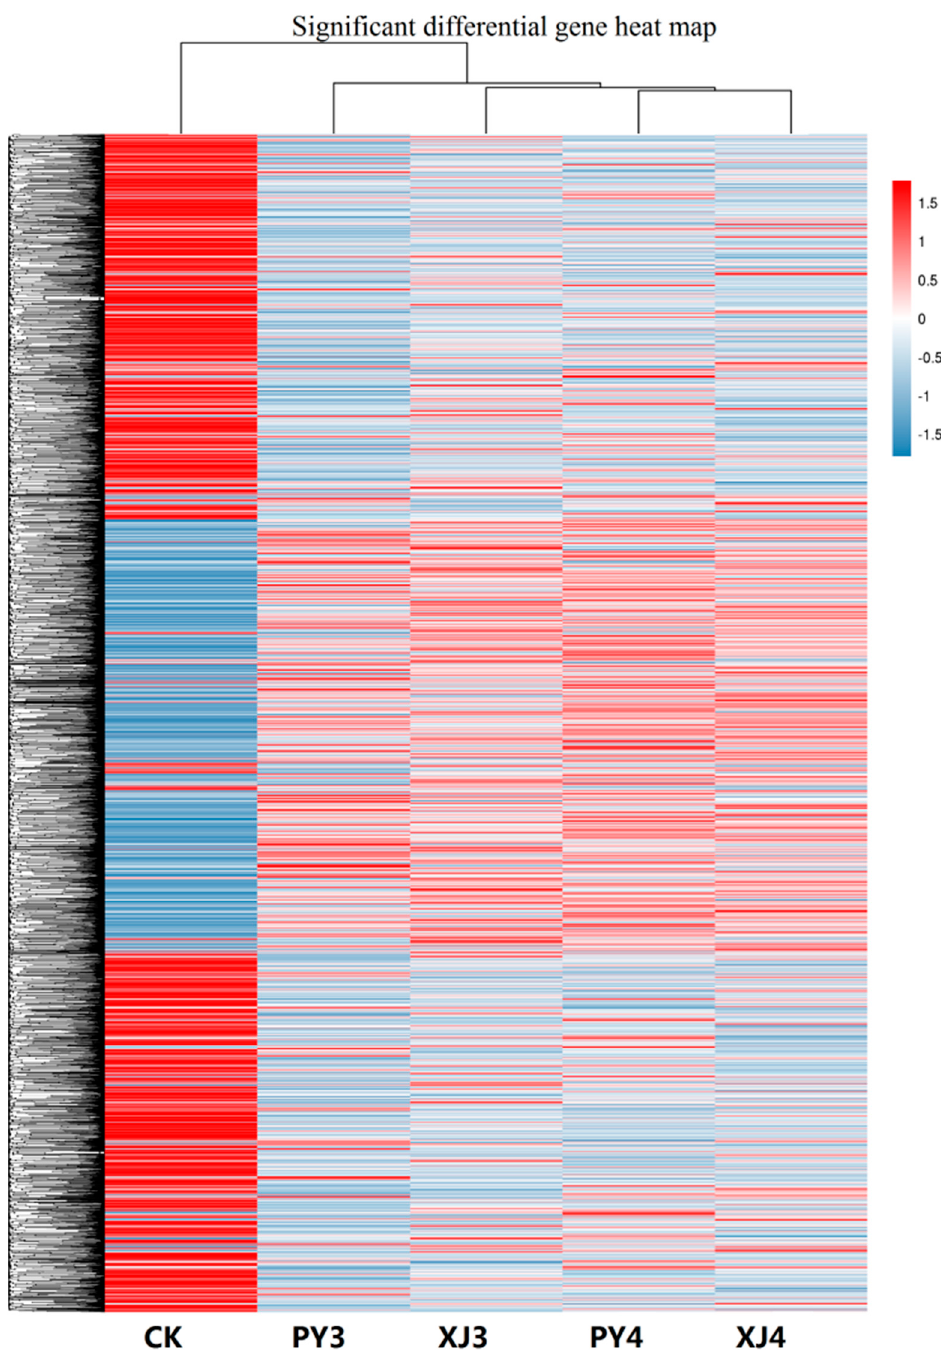
Figure 2. Cluster of significant differentially expressed genes of the five experimental samples. The RPKM (reads per kb per million reads) values of unigenes were used for hierarchical cluster analysis. Expression level was showed by different colors, the redder the higher expression and the bluer the lower. Five treatments were set: CK, only carved; PY3, inoculated with water and sampled 48 h after inoculation; PY4, inoculated with water and sampled at 96 h; XJ3, inoculated with Psa and sampled at 48 h; XJ4, inoculated with Psa and sampled at 96 h.